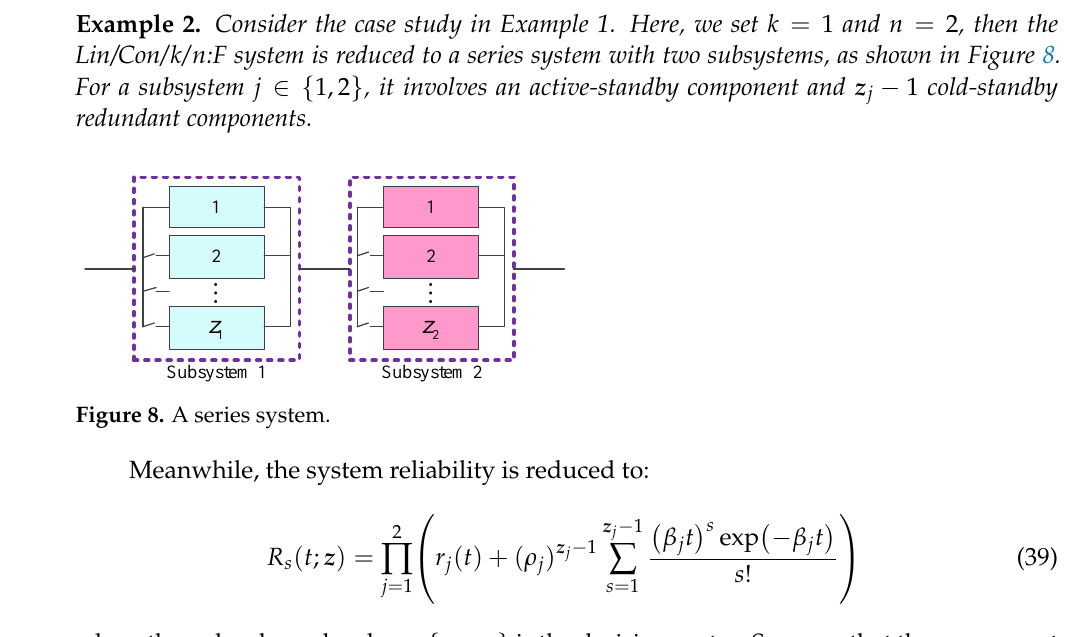
Figure 7. Flowchart of the proposed solution procedure.